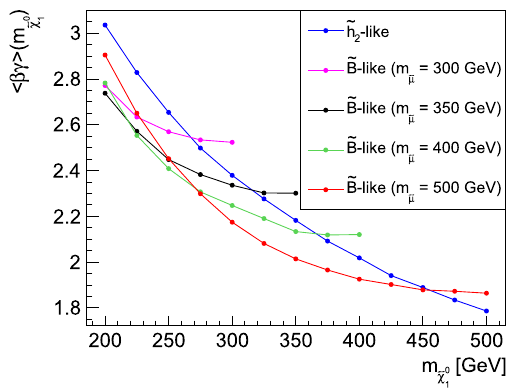
Fig. 6 Mean value of the Lorentz factor (cid:3) βγ (cid:4) for the flying neutralino in both production cases as a function of the neutralino mass m ˜ χ 0